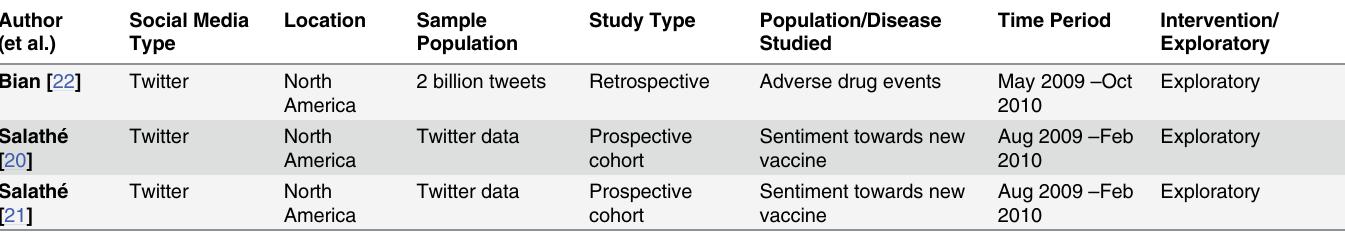
Table 6. Characteristics of 4 medicine or vaccine studies addressing research question 1 a . Author (et al.)